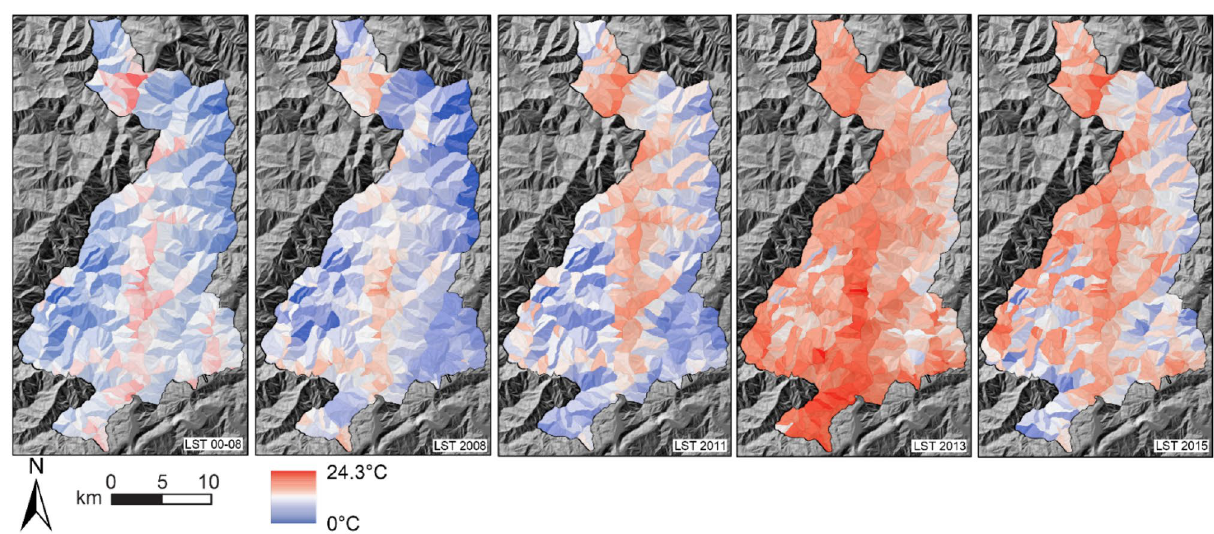
Figure 5. LST data for the WEER-MLI, averaged over the interval between successive image acquisitions. For the 2008 scene, one year of observations prior to the earthquake were considered; for the 2011 scene, data between the imaging date (April 2011) and the earthquake date in (12 May 2008) were taken, and so on. The figure also shows the average LST during eight years before the earthquake (2000–2008), for comparison [software: ArcGIS 10.5, www. arcgis.